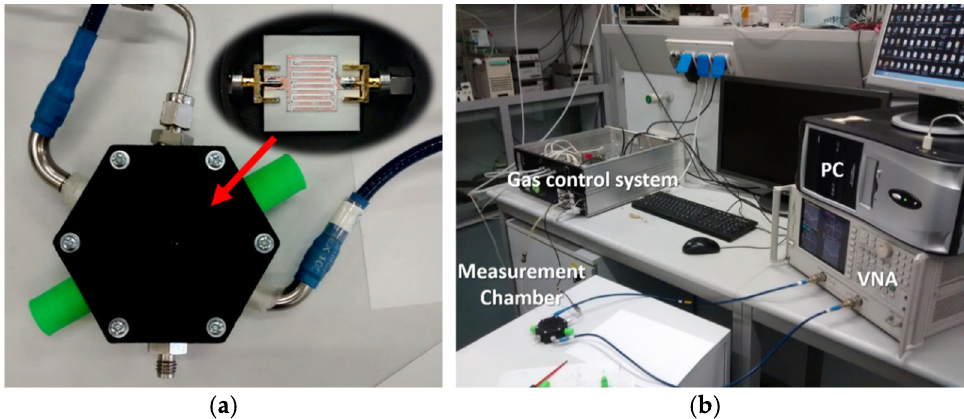
Figure 4. ( a ) Test chamber containing the IDC covered by the sensing material. Two holes of the chamber are used for the inlet and outlet gas pipes, additional two holes are used for the RF cables connections, while the other two apertures are sealed with leak-proof plugs. ( b ) Picture of the experimental measurement